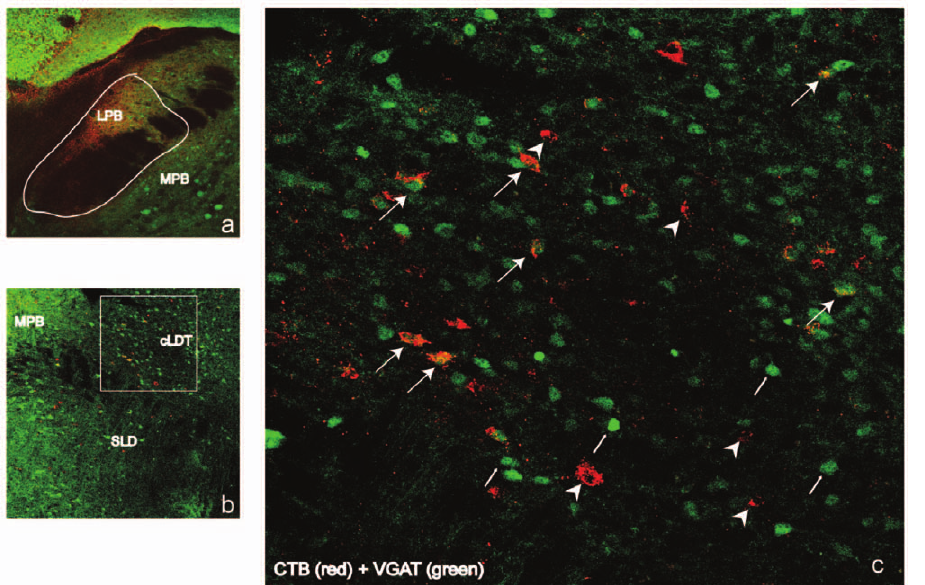
Figure 6. cLDT-SLD glutamatergic neurons project to the parabrachial nucleus. The retrograde tracer CTb injected into the parabrachial nucleus (mostly ventral LPB and MPB) bordered by a white line of VGLUT2-GFP mice (a) labels many neurons that are also glutamatergic in the cLDT- SLD (b, c). The box in (b) is enlarged in (c), where arrows indicate double-labeled neurons and arrowheads indicate single VGLUT2 labeled neurons.